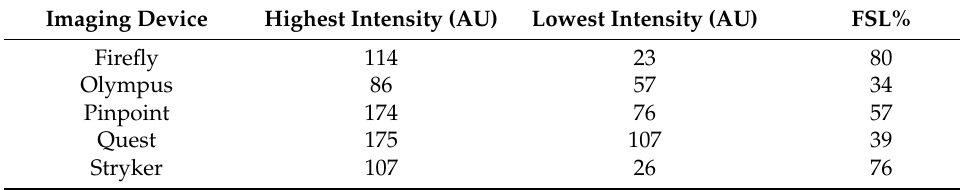
Figure 4. 3D representation of the light distribution among the five different cameras.